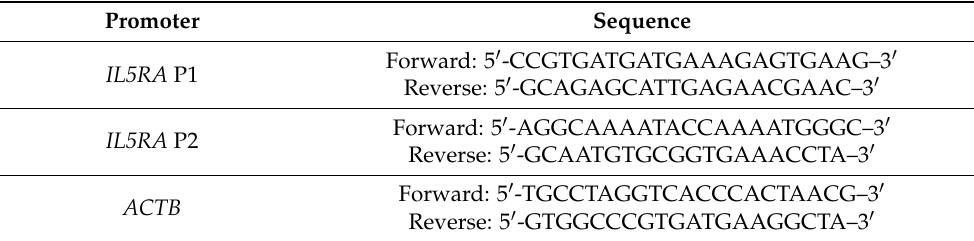
Table 3. Sequences of qPCR primers in ChIP